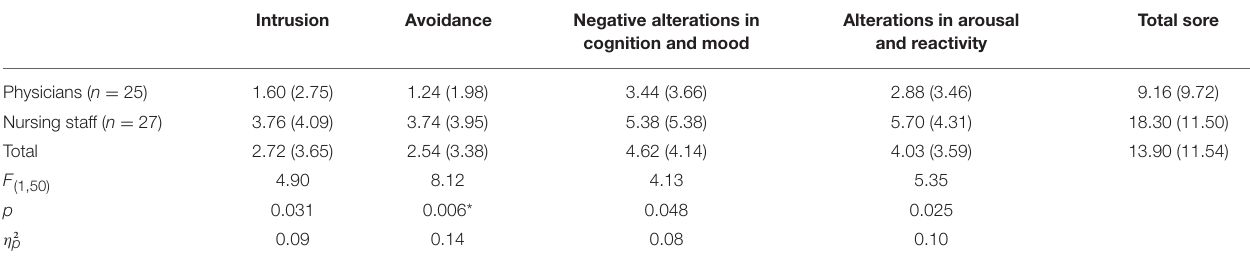
TABLE 2 | Mean scores and standard deviations for the PCL-5 scales and the total score.